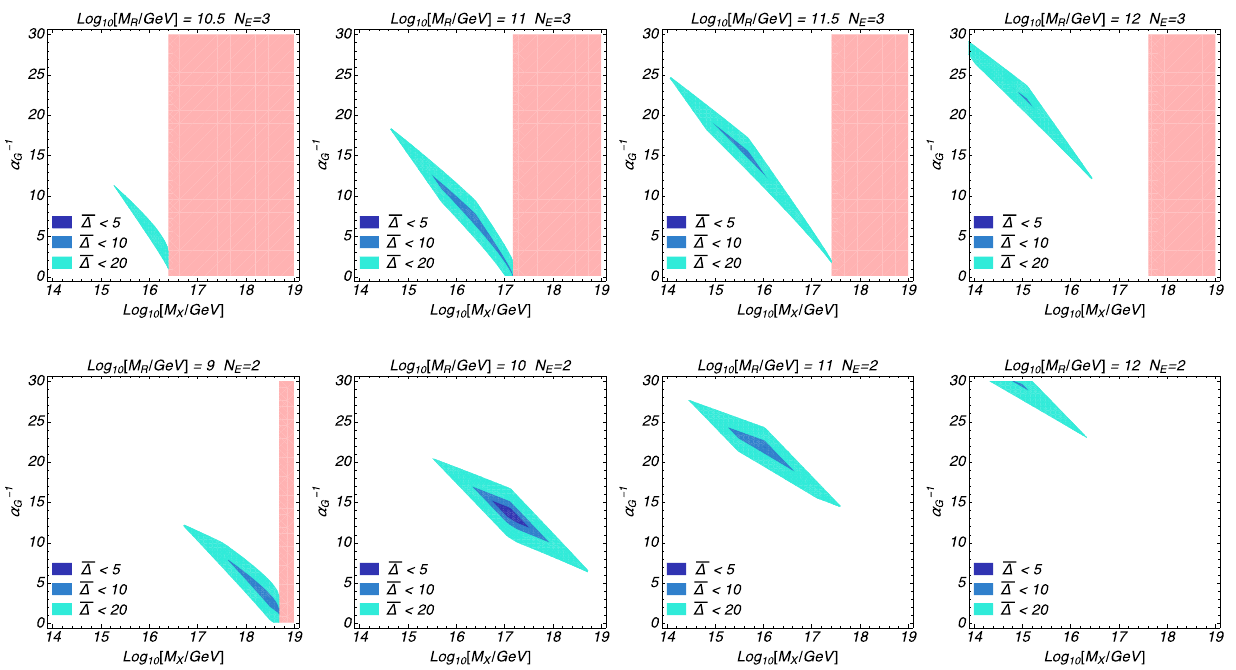
) . mass splittings of the GUT multiplets but also from the mass difference G between the GUT particles and M X . The pink shade region is excluded as M X is above the Landau pole of α 1 , 2 , 3 (μ, M R ) . We confine ourselves to the region with M X (cid:12) M Pl , so that the effective field theory without gravity is